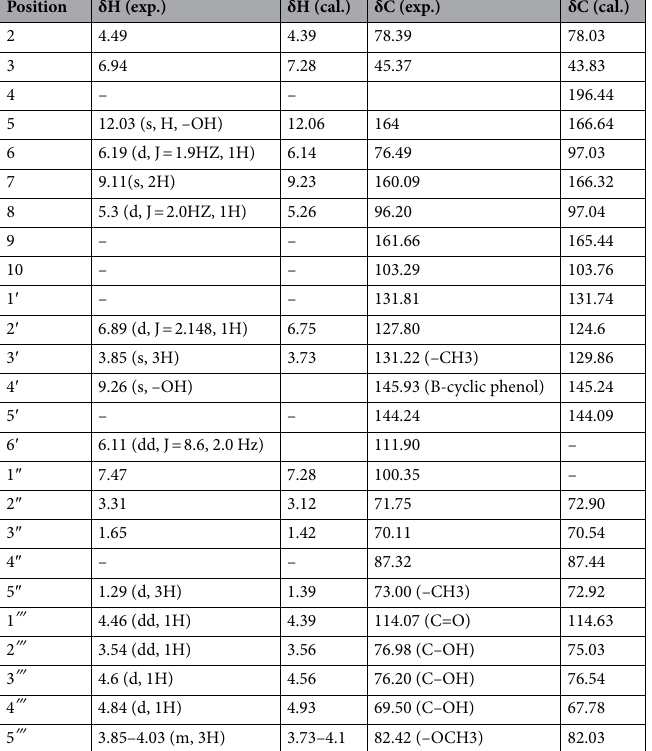
Table 1. Experimental and calculated 1 H and 13 C NMR data of new compound.